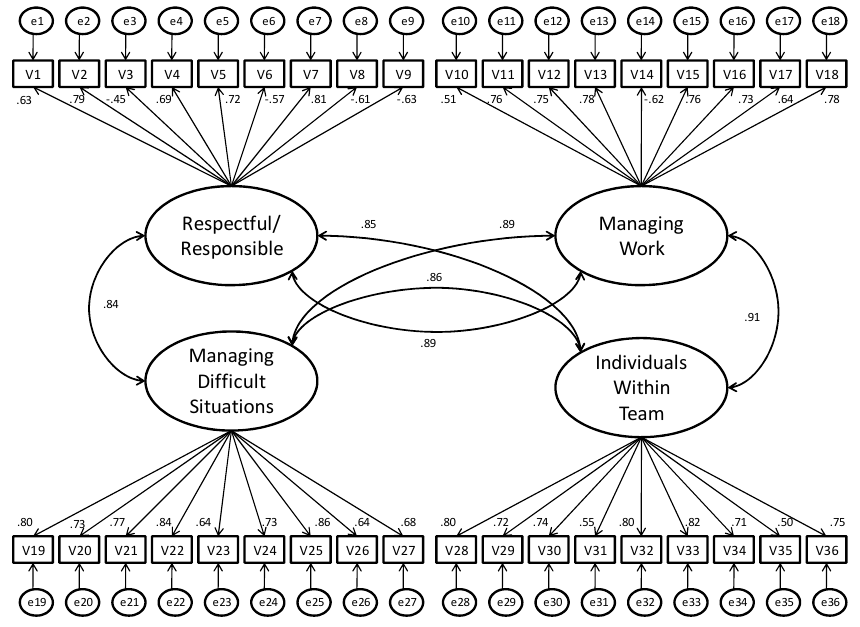
Figure 1. The Four-Factors proposed model and standardized path coefficients.